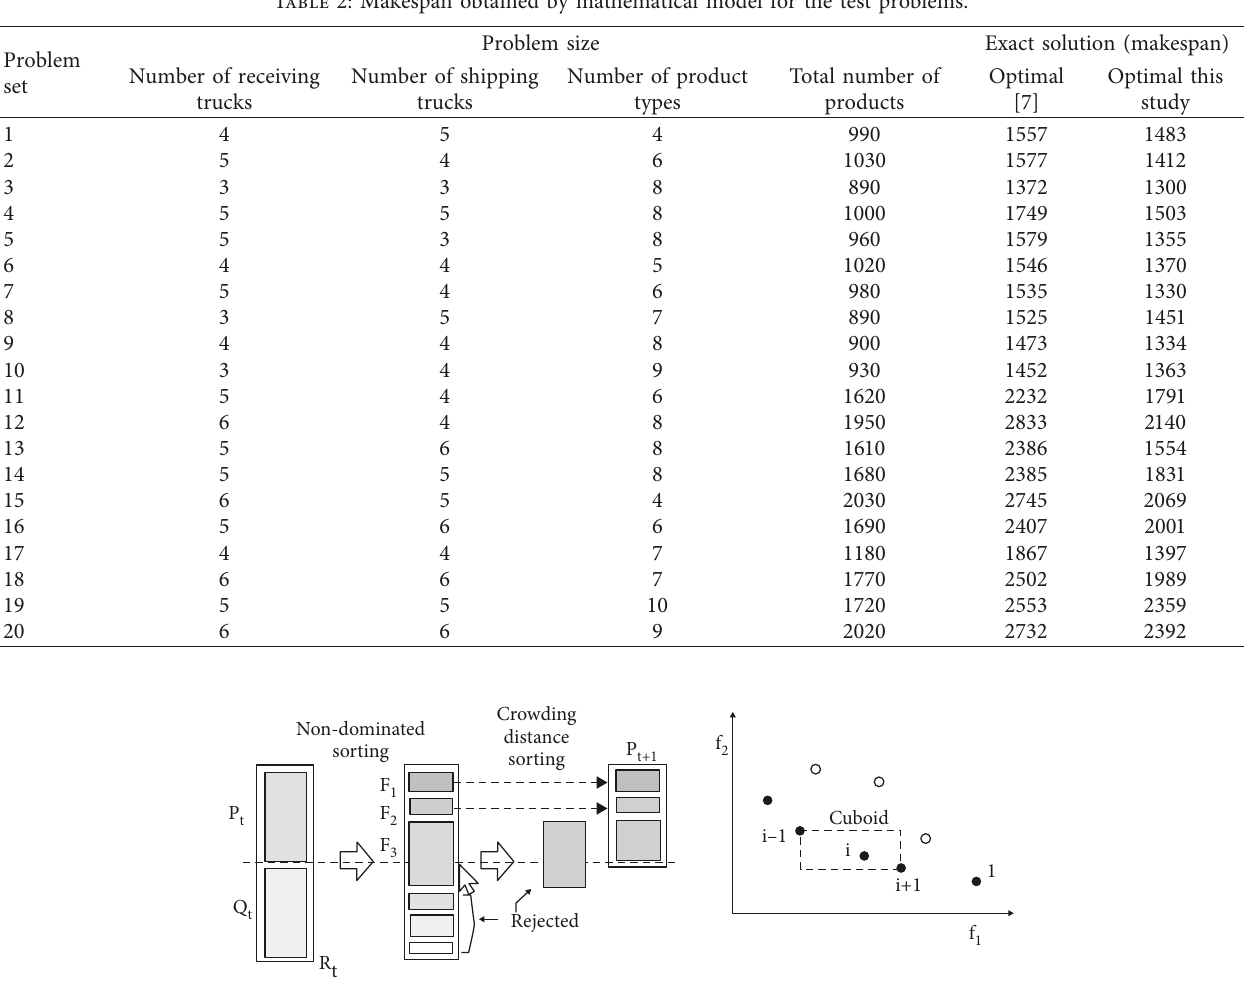
Figure 3: Nondominated sorting genetic algorithm II